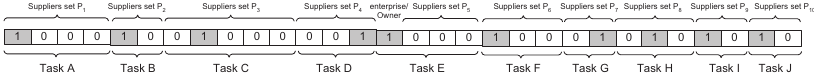
Figure 4. The Final Optimal Allocation Results of Design Tasks of 5-MW Wind Turbine Products.